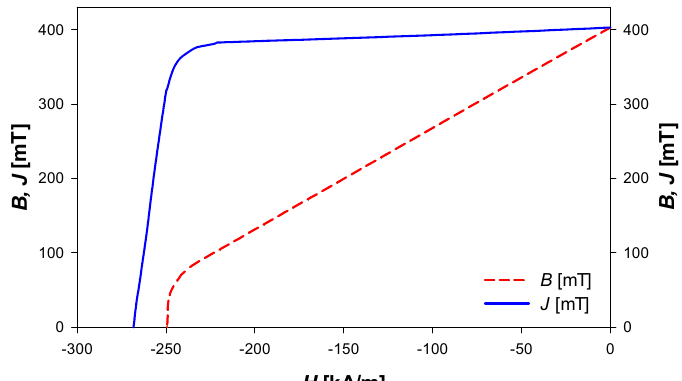
Figure 2. Demagnetization curve of the ferrite HF 30 / 26 permanent magnet material at 20 ◦ C. Adapted from [28]. Magnetic polarization J and magnetic flux density B versus the magnetic field H , where B = J + µ 0 · H . Table 2 shows the main parameters of the finite element analysis (FEA) model generated in this work by means of the Altair Flux TM FEA